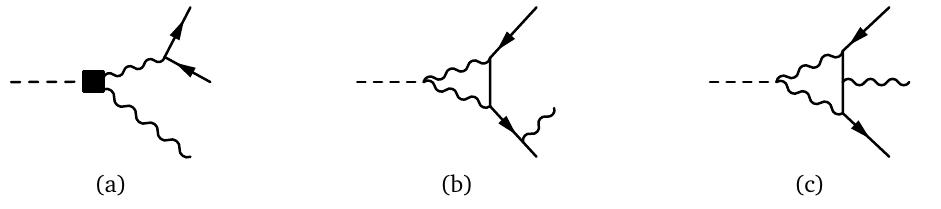
Figure 3: Diagrams contributing to the process H → ¯ (cid:96)(cid:96)γ . In (a) the square vertex represents an insertion of the one-loop effective action coupling to two photons or a Z and photon. In (b) and (c) the Higgs boson decays to two fermions via a loop containing two W s or two Z s, a photon is then either radiated by an external or the internal fermion